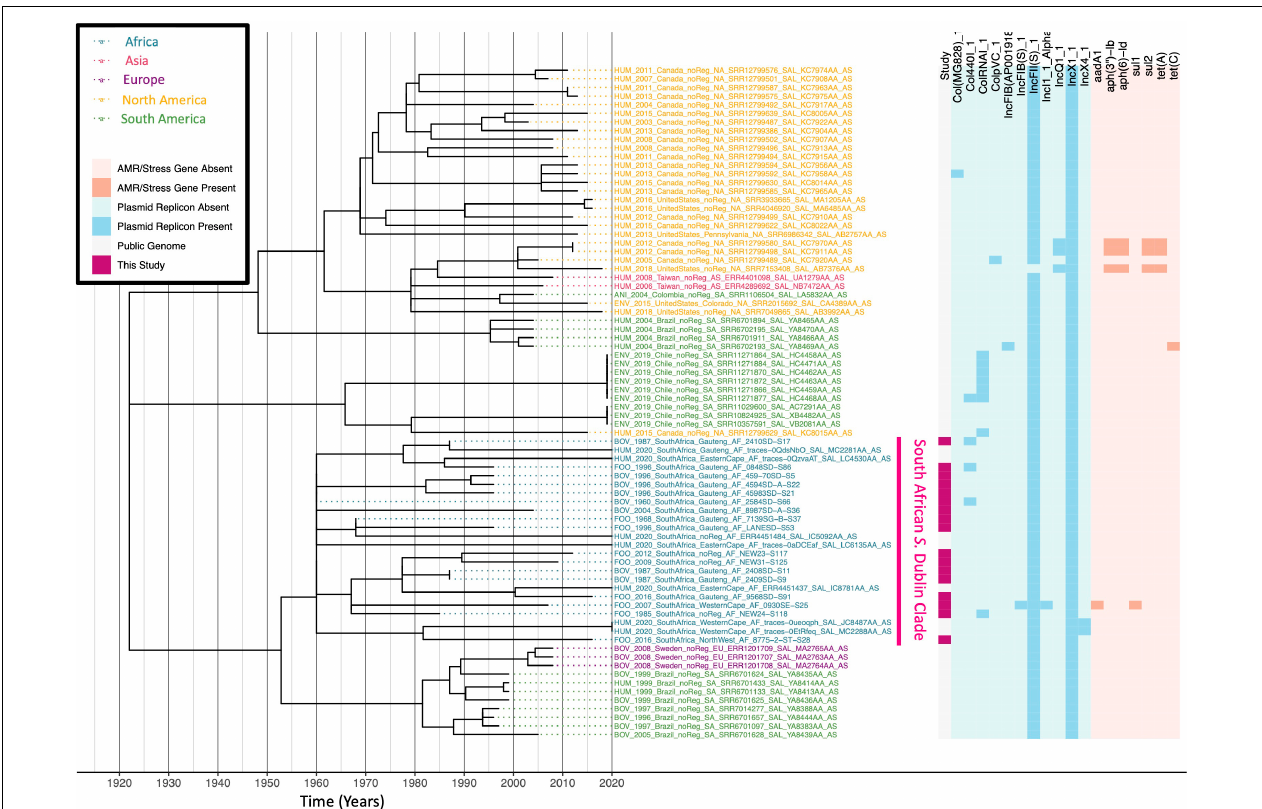
FIGURE 4 | Maximum likelihood phylogeny constructed using core SNPs identified among 78 S. Dublin genomes within the S. Dublin Small Subclade (61 publicly available genomes, plus 17 sequenced here). Tip label colors denote the continent from which each strain was reported to have been isolated. A pink clade label to the right of the tip labels denotes a clade of South African isolates, which encompasses 17 of the 18 S. Dublin isolates sequenced in this study, plus seven publicly available South African isolates. The heatmap to the right of the phylogeny denotes: (i) whether an isolate was sequenced in conjunction with this study (dark pink) or not (gray; “Study”); the presence and absence of (ii) plasmid replicons (blue) and (iii) antimicrobial resistance (AMR) determinants (orange). The phylogeny was rooted and time-scaled using LSD2, with branch lengths reported in years ( X -axis). Core SNPs were identified among all genomes using Parsnp. AMR determinants were identified using ABRicate, the NCBI AMR determinant database, and minimum identity and coverage thresholds of 75 and 50%, respectively. Plasmid replicons were identified using ABRicate and the PlasmidFinder database, using minimum identity and coverage thresholds of 80 and 60%, respectively. The phylogeny was constructed and annotated using IQ-TREE and bactaxR/ggtree,